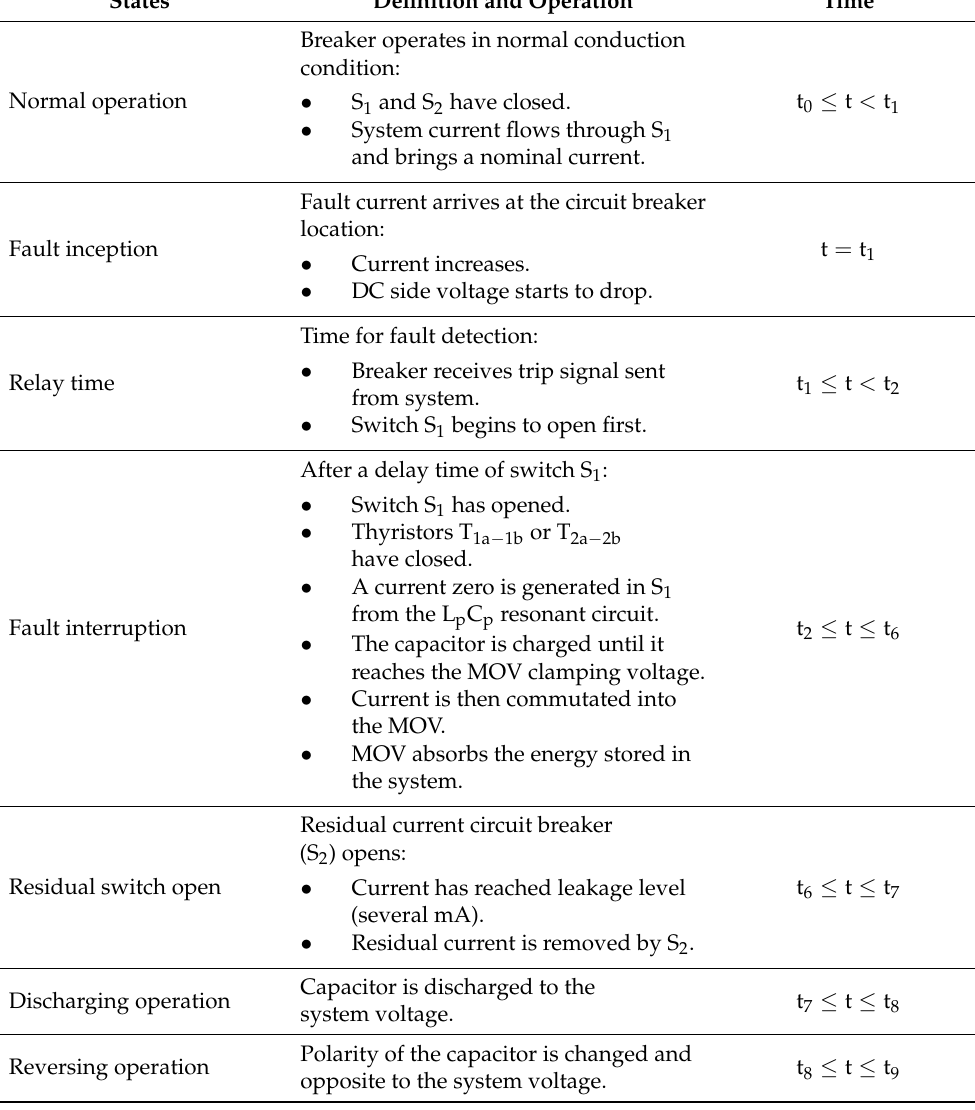
Table 1. Summarizing sequence of operation of the